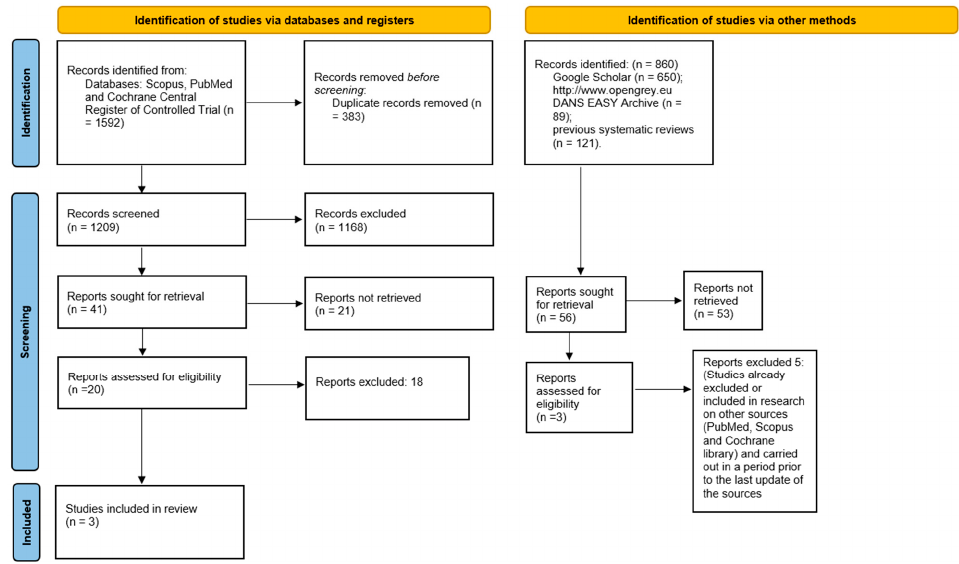
Figure 1. Entire selection and screening procedures are described in the PRISMA flowchart.